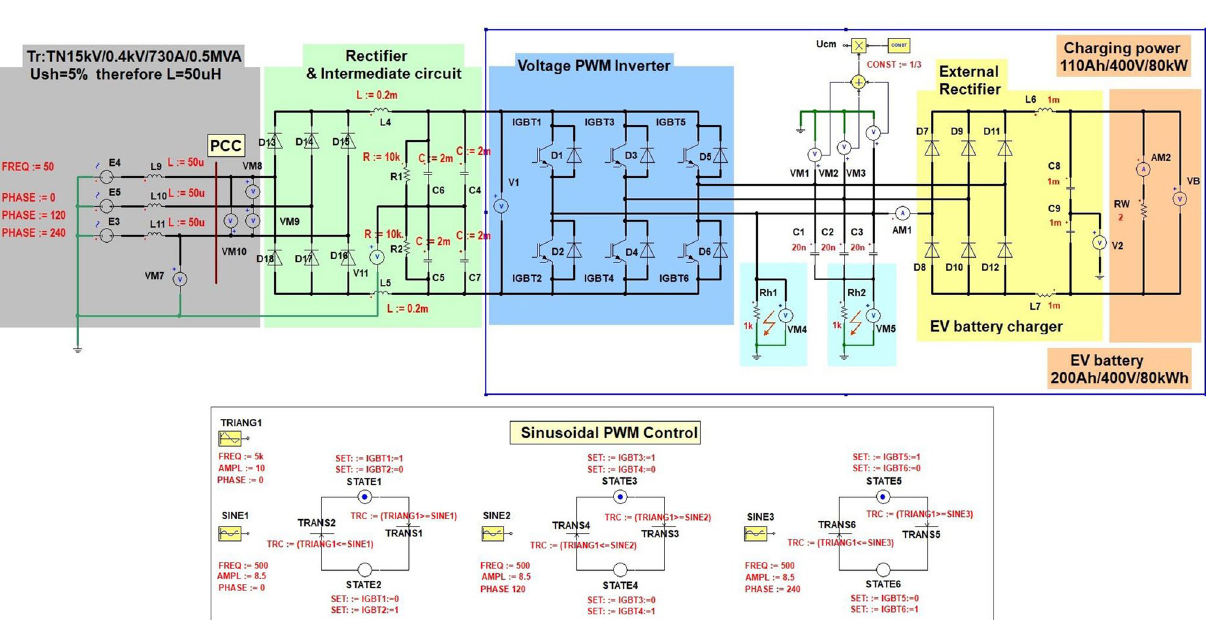
Figure 5. The model of the EV battery charging system with a drive VFC (rectifier and intermediate circuit + voltage PWM inverter) feed by transformer in the TN